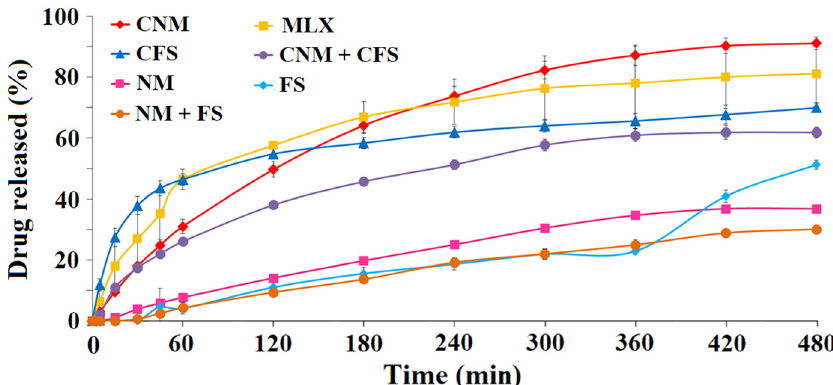
Figure 4. Release profiles at pH 6.8 for MLX raw material and multiparticulate colon systems of 0.50–1.41 mm diameter size: FS, NM, NM + FS, CFS, CNM and CNM + CFS.